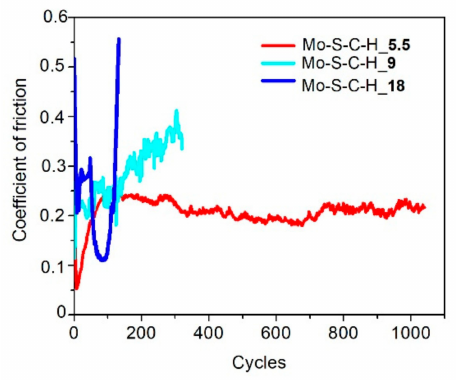
Figure 8. Characteristic evolution of the friction coe ffi cient as a function of the cycle number for the Mo–S–C–H thin-film coatings obtained by reactive PLD at the pressures of H 2 S gas of 5.5, 9 and 18 Pa. Pin-on-disk tribometer testing was conducted in wet friction conditions (RH ~58%) at 22 ◦ C.